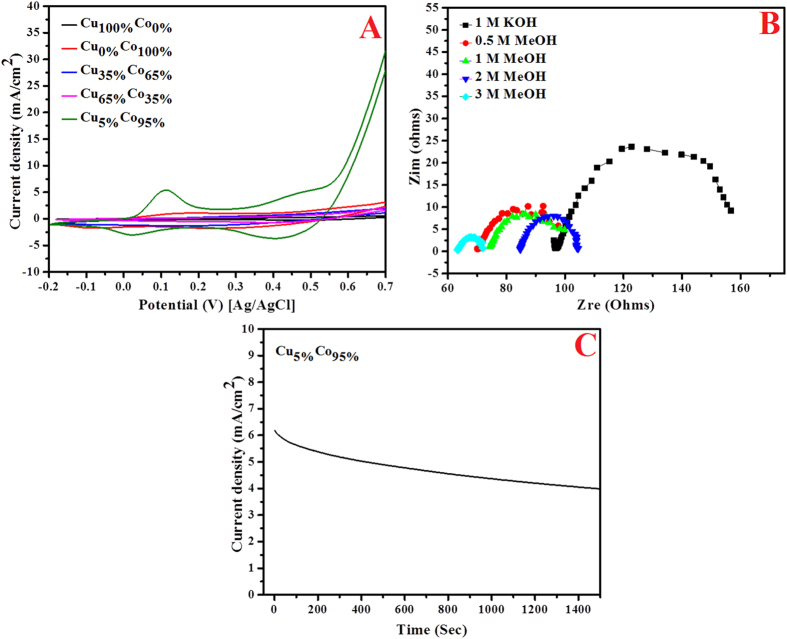
(A) CV for 50th cycle of the activation process in presence of 1 M KOH (Scan rate 100 mV/s) for the carbon nanofibers containing Cu0%Co100%, Cu35%Co65%, Cu65%Co35%, Cu5%Co95% and Cu100%Co0% nanoparticles (B)Nyquist plot of Cu5%Co95%-CNFs at different concentrations of methanol and (C) Chronamperometery for Cu5%Co95%-CNFs electrode at V = 0.4 V vs. Ag/AgCl in methanol in alkaline medium (3 M methanol in 1 M KOH).